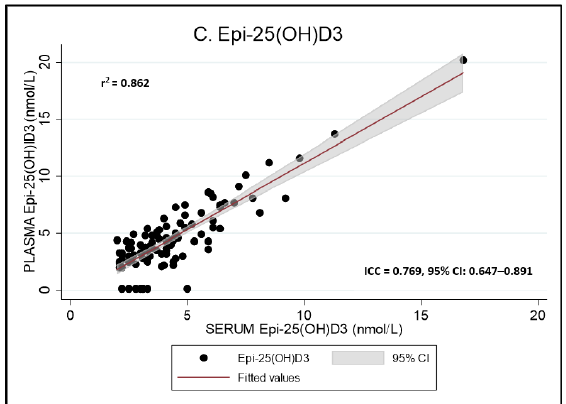
Figure 1. 25(OH)D: 25-hydroxyvitamin D. ( A – C ) Scatter plot with Pearson ( r 2 ) and intraclass correlation coefficients (ICC) between serum and plasma concentrations of vitamin D analogues, quantified using LC-MS/MS. ( A ) Total 25(OH)D, ( B ) 25(OH)D 3 and ( C ): Epi-25(OH)D 3 . 95% CI, 95% confidence interval. All results expressed as nmol/L. The Bland-Altman plot shows a mean total concentration bias for serum vs. plasma of 7.63 mol / L (95% CI 5.36, 9.90, p = < 0.001) for total 25(OH)D, 7.38 nmol / L (95% CI 5.28, 9.48 p = < 0.001) for 25(OH)D 3 , and 0.39 nmol / L (95% CI 0.14, 0.64, p = 0.003) for Epi-25(OH)D 3 (Figure 2).